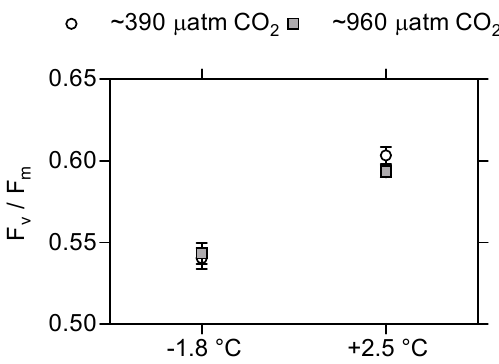
Fig. 2. Maximum quantum yield ( F v / F m ) measurements after 14 days of treatment in Experiment A. Error bars are displaying stan- dard error ( n =